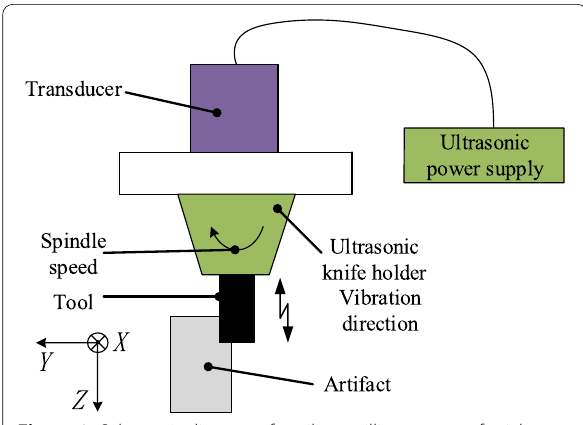
Figure 2 Schematic diagram of auxiliary milling system of axial supersonic vibration